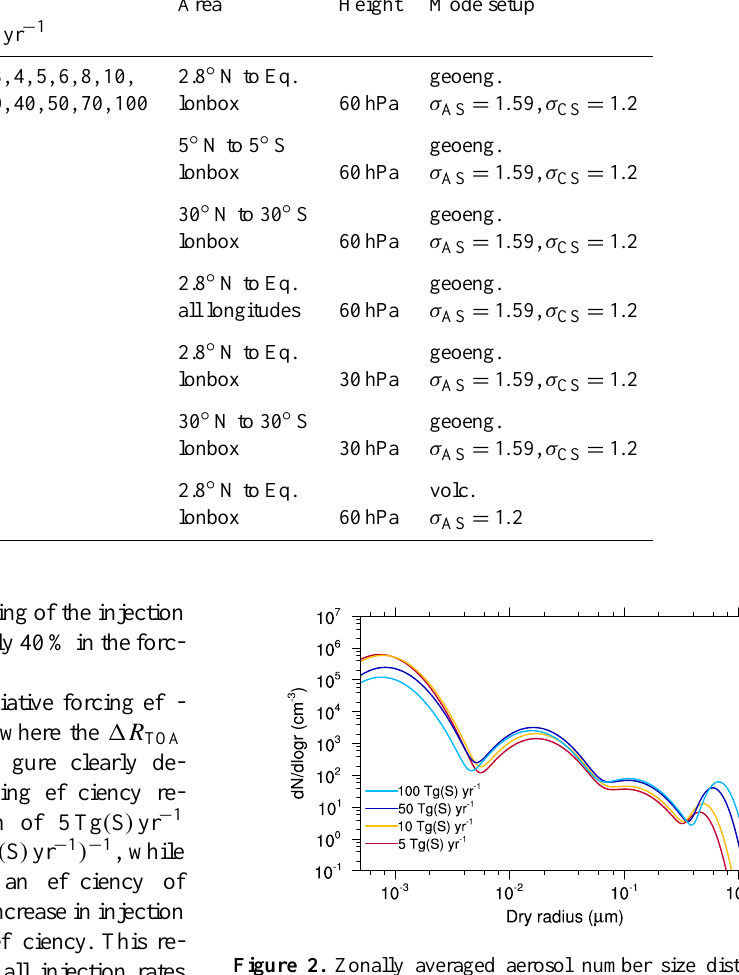
Figure 2. Zonally averaged aerosol number size distribution at 54hPa height at the Equator for different injection rates. Given are values for nucleation mode (radius (r) ≤ 5nm), Aitken mode (5nm ≤ r ≤ 50nm), accumulation mode (0 . 05µm ≤ r ≤ 0 . 2µm) and coarse mode ( r ≥ 0 . 2µm). Only particles in accumulation and coarse modes are radiatively active. Scattering of SW radiation is strongest in accumulation mode and gets less effective with increas- ing particle size (Pierce et al.,